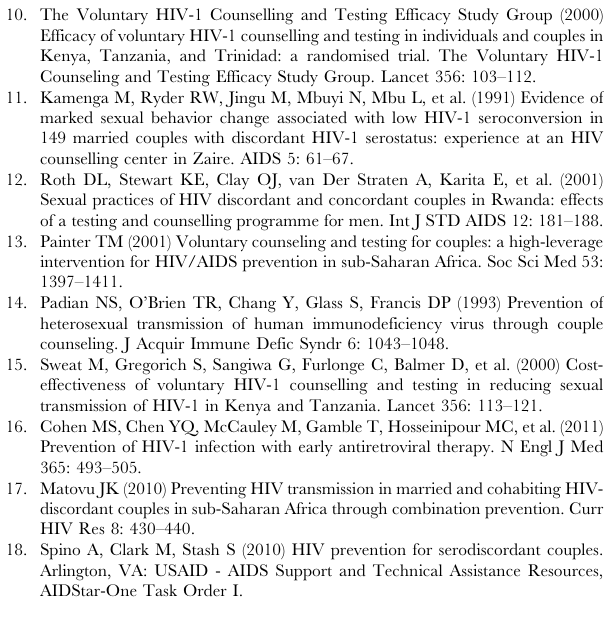
Figure S1 Flow model for the variant assuming monog- amy. (TIF) Supporting Information S1 Mathematical